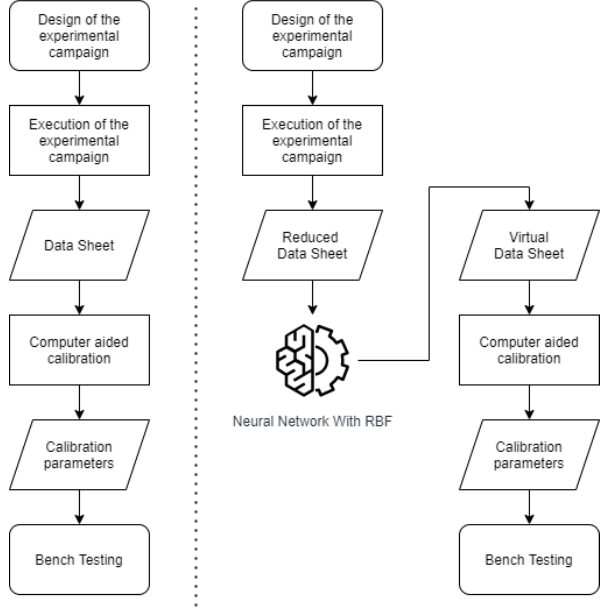
Figure 3. Scheme of the improved calibration